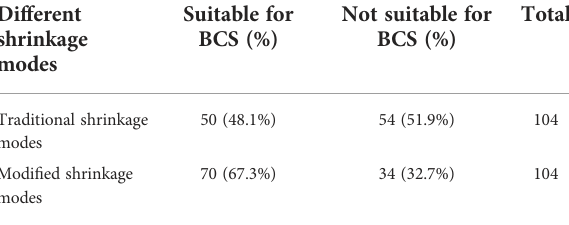
TABLE 3 Candidates of BCS according to the different shrinkage classi fi cation modes.